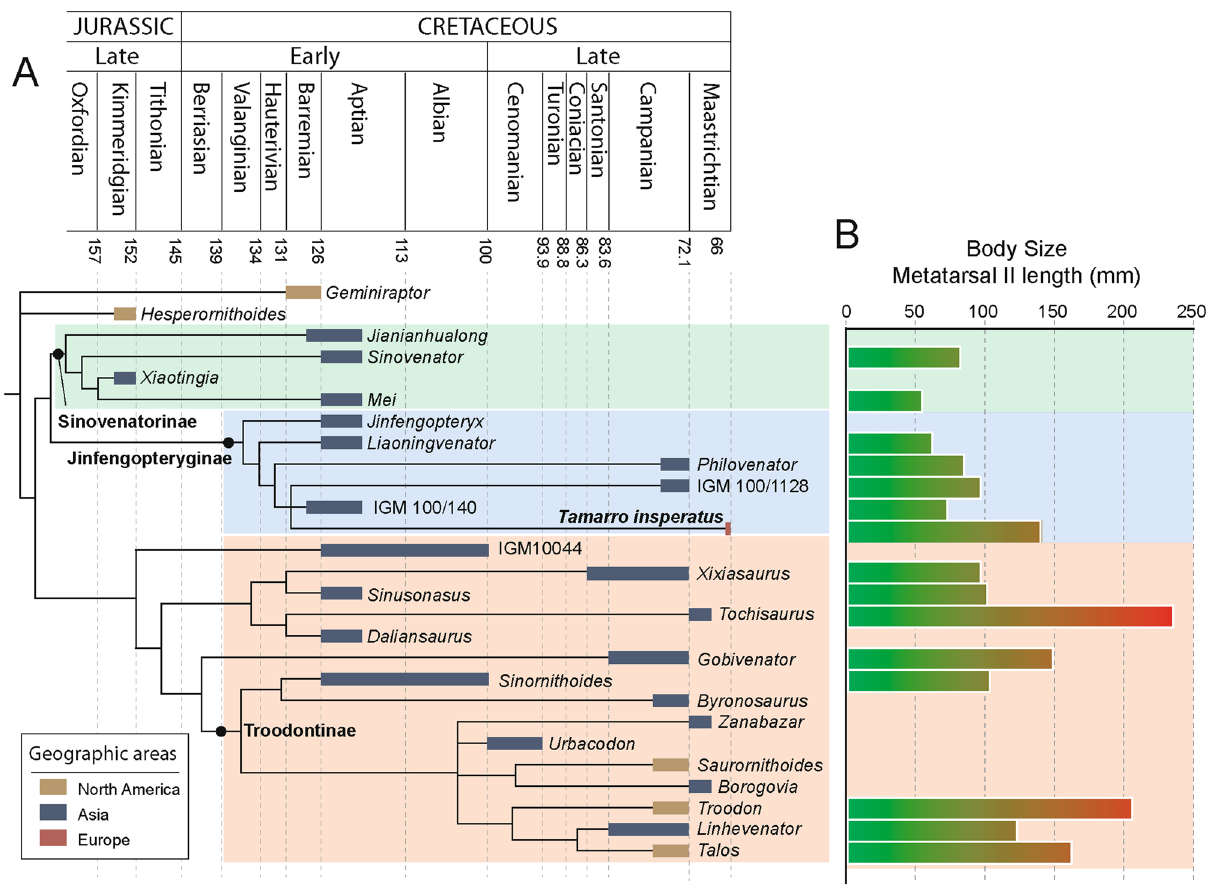
Figure 3. Phylogenetic relationships of Tamarro insperatus (MCD-7073) gen. et sp. nov. Simplified time- calibrate topology of the strict consensus phylogenetic trees (CI: 0.073, RI: 0.615) of 10 most